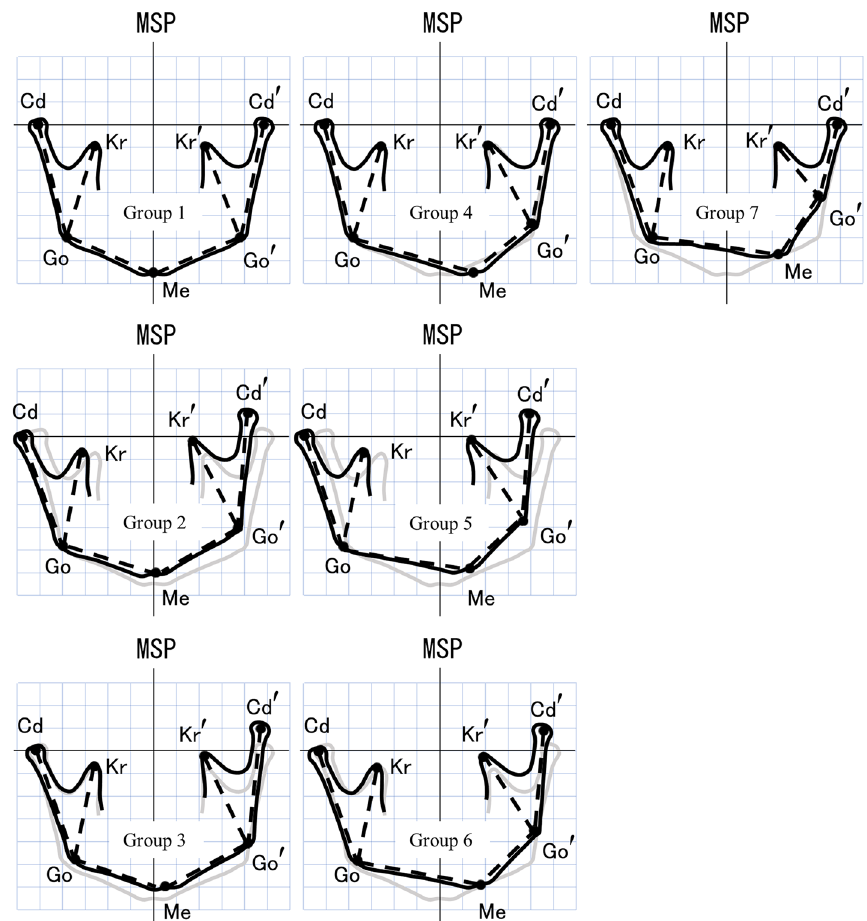
Fig. 5 Conceptual diagram representing the characteristics of each group. (Gray line shows the diagram of Group1 as a symmetrical shape of